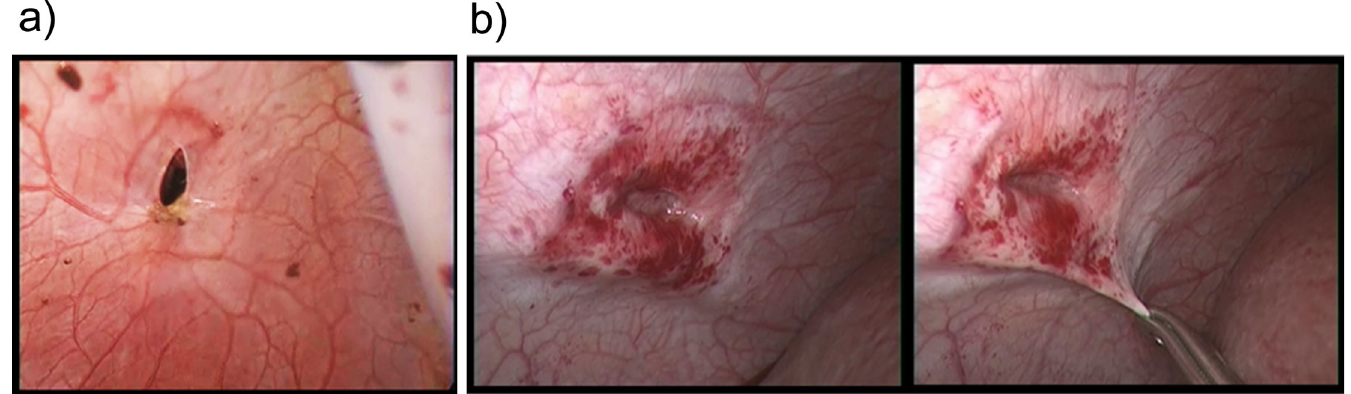
Fig 3. Natural course of a non-sutured 5-mm intercostal port site. a) Immediately after removal of an intercostal port. b) Six months later.